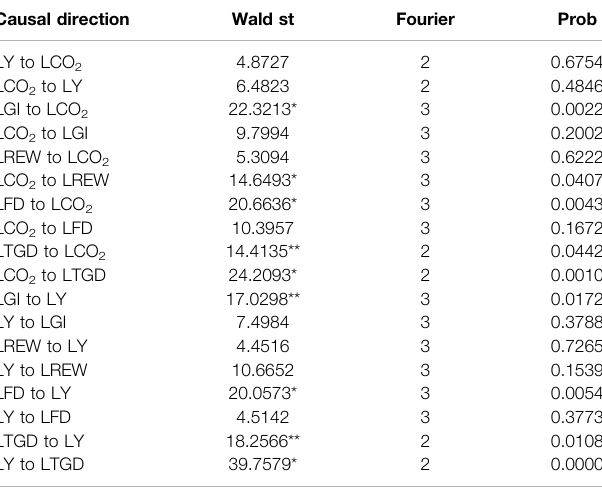
TABLE 7 | Gradual shift causality results. Causal